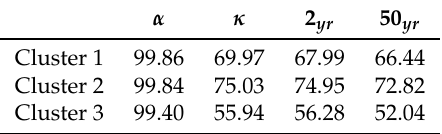
Figure 5. Estimated return periods of deficit volumes. Dashed line shows regional quantile function, darker area the 25th and 75th, light area 5th and 95th percent quantile calculated from the bootstrap samples. Table 5. Percentage decrease in uncertainties in parameter and return level